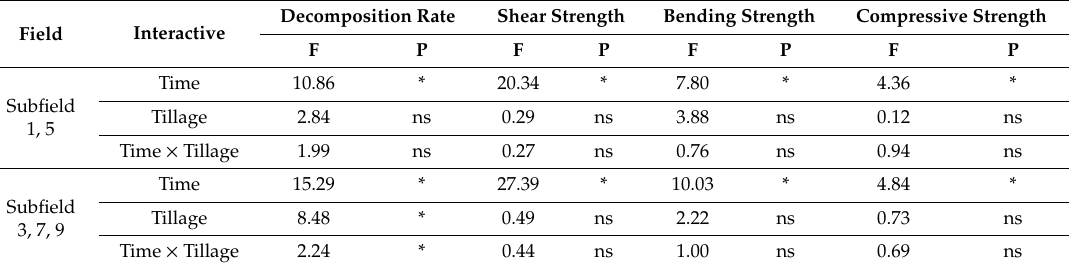
Table 2. Two-way ANOVA of the wheat straw over